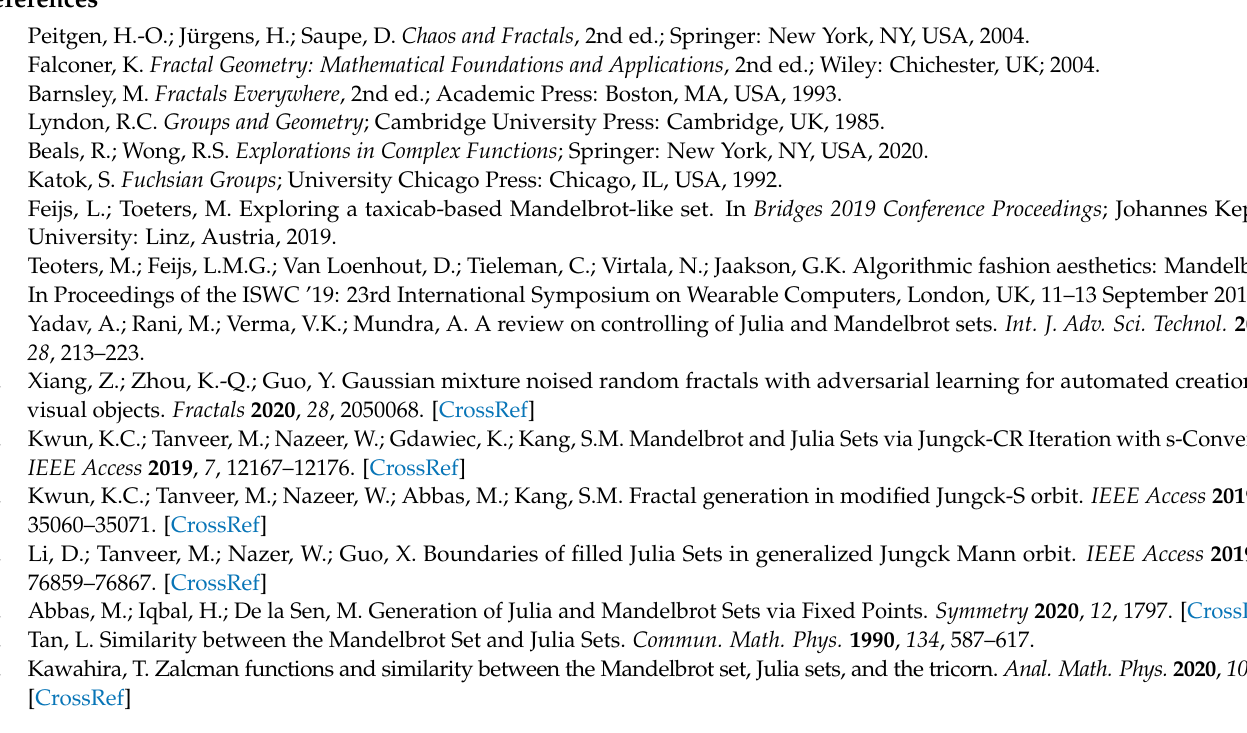
Table[{x, y, JSMobptbuild[x + I y, {a, b, c, d}, l, j]}, {x, xmin, xmax, xs}], {y, ymin, ymax, ys}], 1], ColorFunction -> (Blend[{Black, Blue, Red, RGBColor[0, .8, 0], Yellow, Orange, Red}, #] &), ColorFunctionScaling -> False, PlotRange -> All] // Quiet JSplotallclassicMobbuild[{0, .3851450, 1, 0}, -.45 + .05 I,